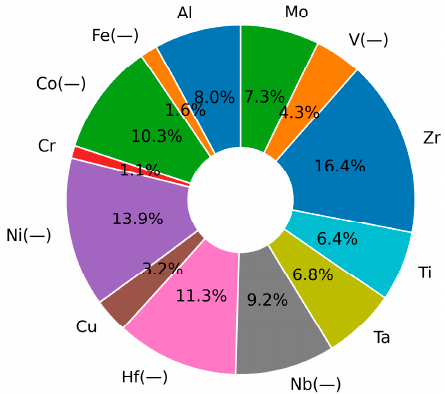
Figure 6. Influence of coefficients in the lasso regression